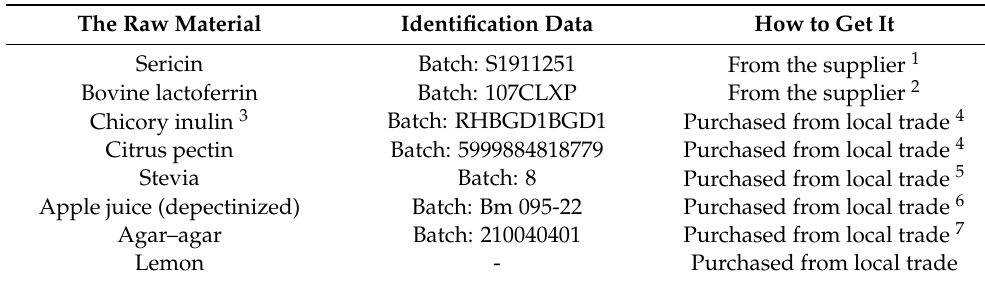
Table 5. Sericin used for making desserts. The Raw